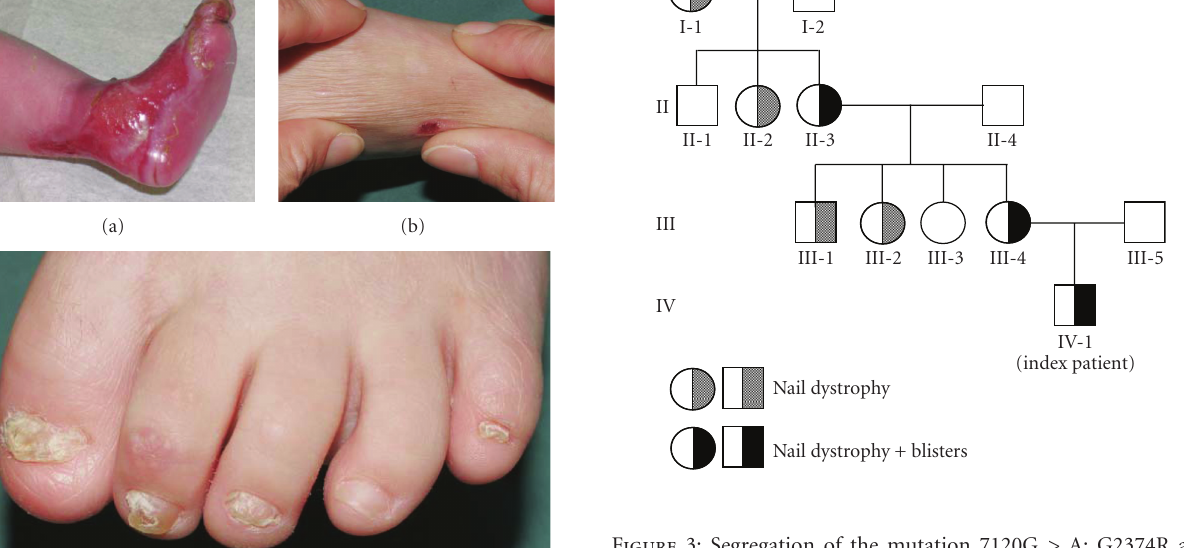
Figure 3: Segregation of the mutation 7120G > A: G2374R and its phenotypic features are shown in the pedigree of the family. The index patient (IV-1) and his grandmother (II-3) show blisters and nail dystrophy. His mother (III-4) presented with blisters solely in childhood and appears with nail dystrophy. All other family members carrying this mutation present with nail dystrophy without